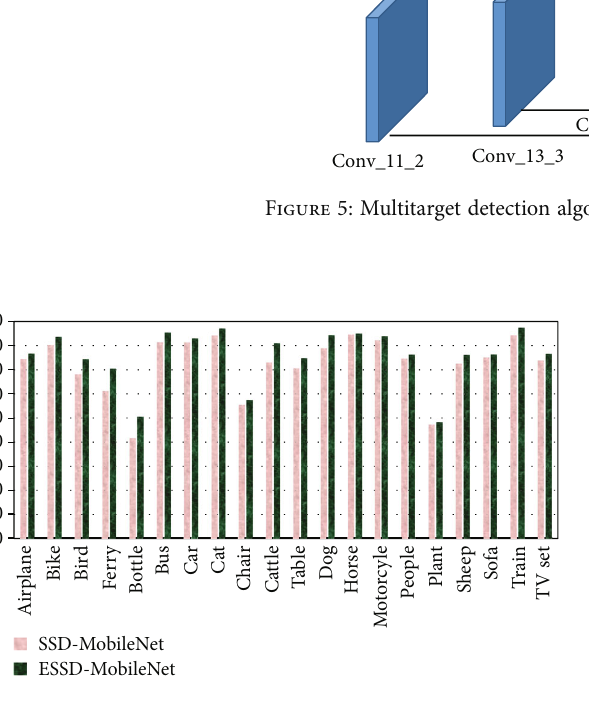
Figure 6: Comparison of AP results for identi fi cation of di ff erent target categories (changed to grouped histogram).